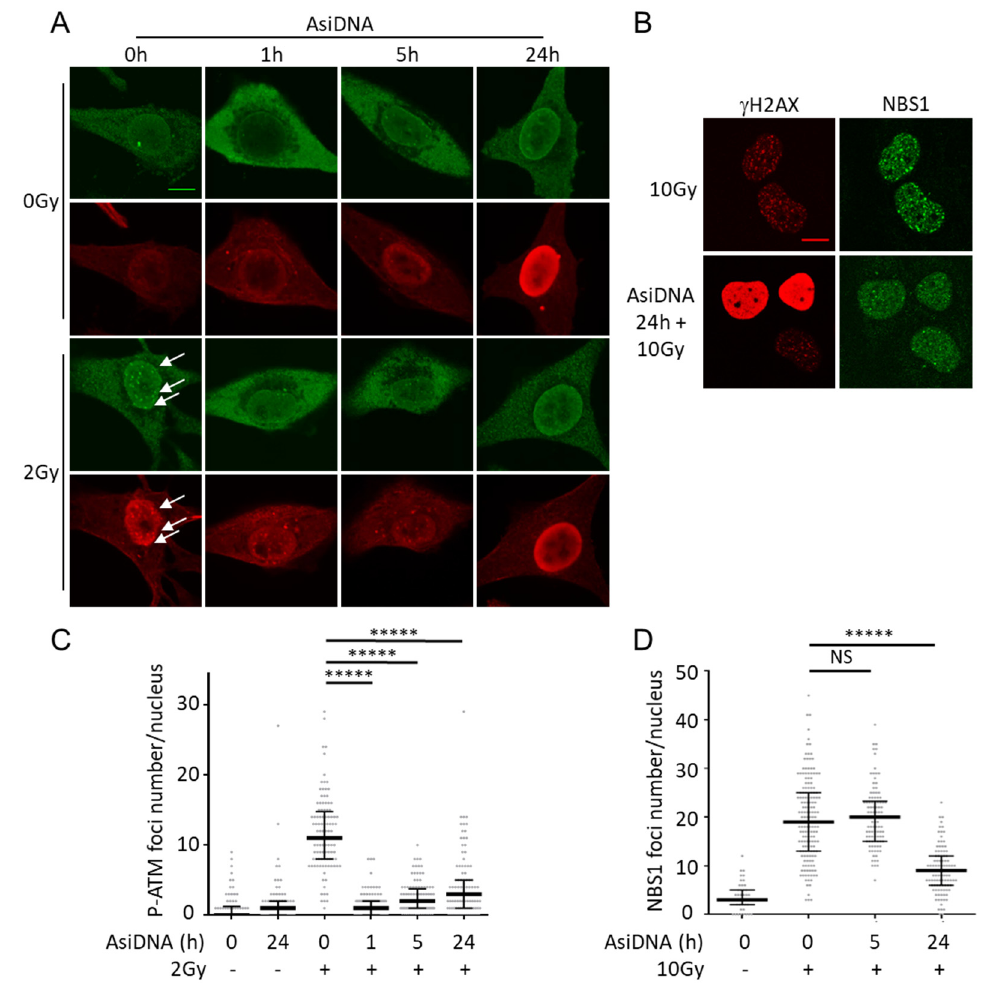
Figure 3. ATM phosphorylation in SK28 cells treated for different times with AsiDNA, and inhibition of NBS1 foci formation after irradiation. ( A ) ATM phosphorylation (green) and γ H2AX (red) were detected by immunostaining in SK28 cells treated with AsiDNA at different times indicated in abscissa and irradiated or not at 2Gy. White arrows indicate foci with colocalization of P-ATM and γ H2AX. Scale bar: 10 µ m. ( B ) Inhibition of NBS1 recruitment after irradiation in MRC-5sv cells treated 24 h with AsiDNA and exposed to 10Gy. Scale bar: 10 µm. ( C ) Quantification of P-ATM foci per nucleus after various treatments. ( D ) Quantification of NBS1 foci per nucleus after various treatments. Mann-Whitney test: ***** p value < 0.00001, NS: not significant.